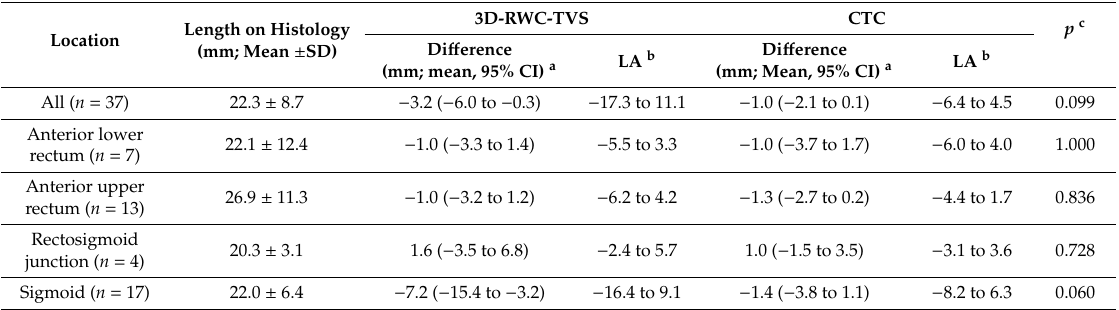
Table 3. Di ff erence between the size of the largest nodule estimated by imaging techniques and that measured on